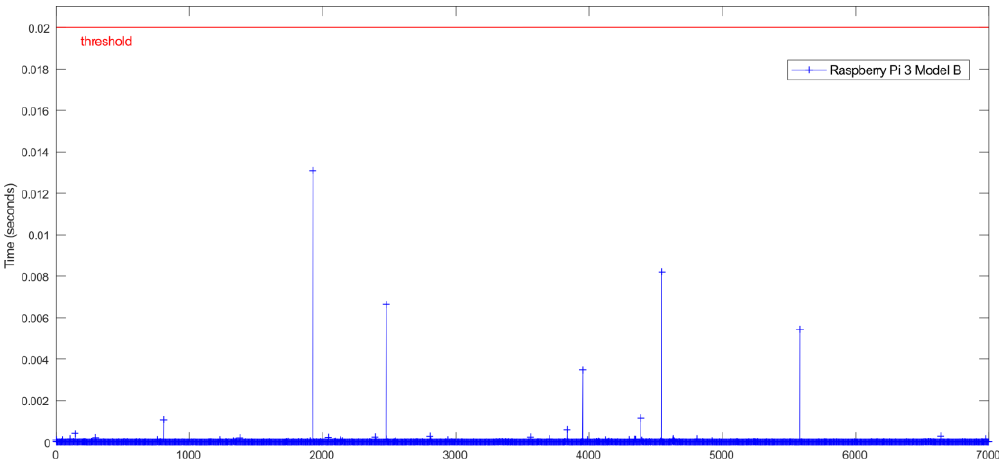
Table 4. Test 1. Processing time on Raspberry Pi 3 Model B and Intel Edison.